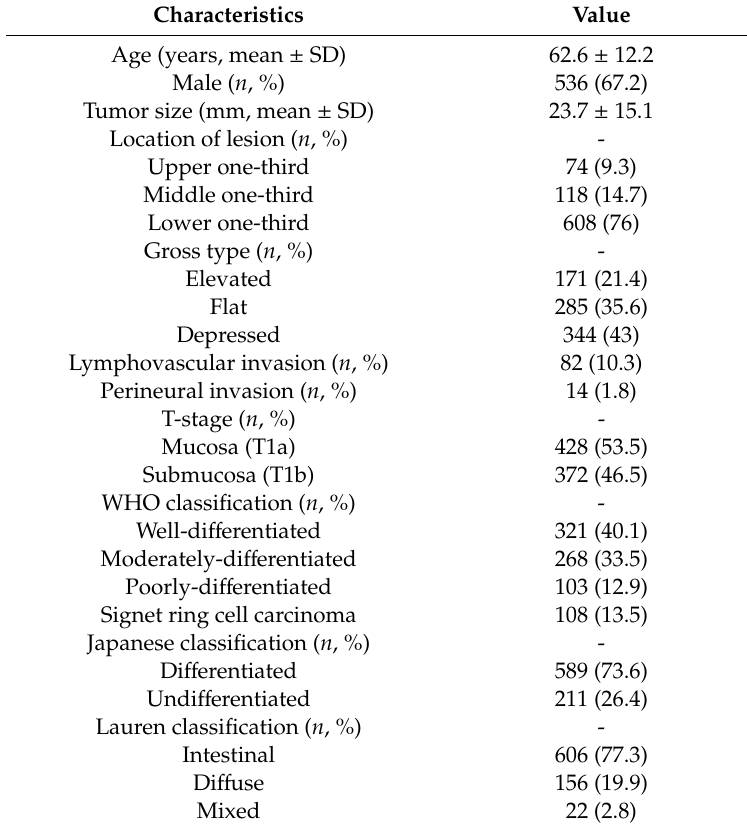
Table 1. Baseline clinicopathological characteristics of all